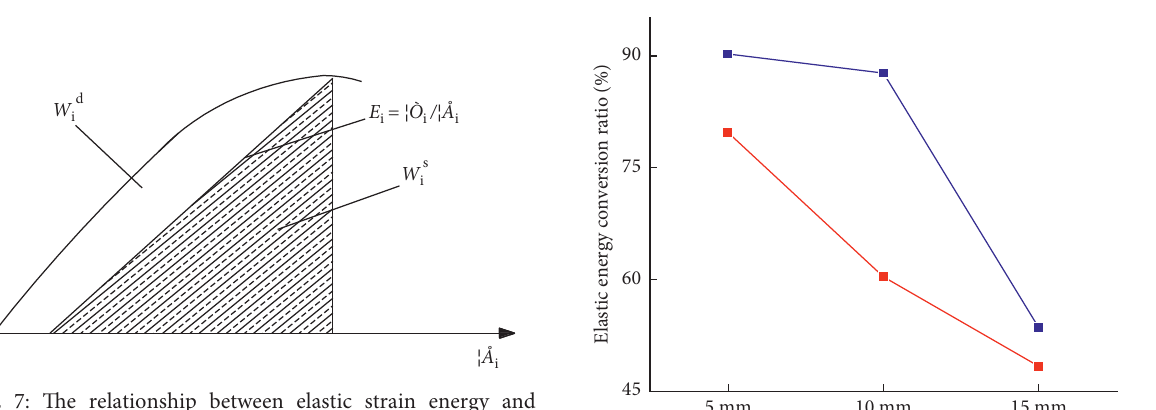
Figure 6: Failure patterns of the rock sample with different diameters of the vertical hole. (a) Failure pattern of the intact rock sample. (b) Failure pattern of the rock sample with Φ 5 mm hole. (c) Failure pattern of the rock sample with Φ 10 mm hole. (d) Failure pattern of the rock sample with Φ 15 mm hole.